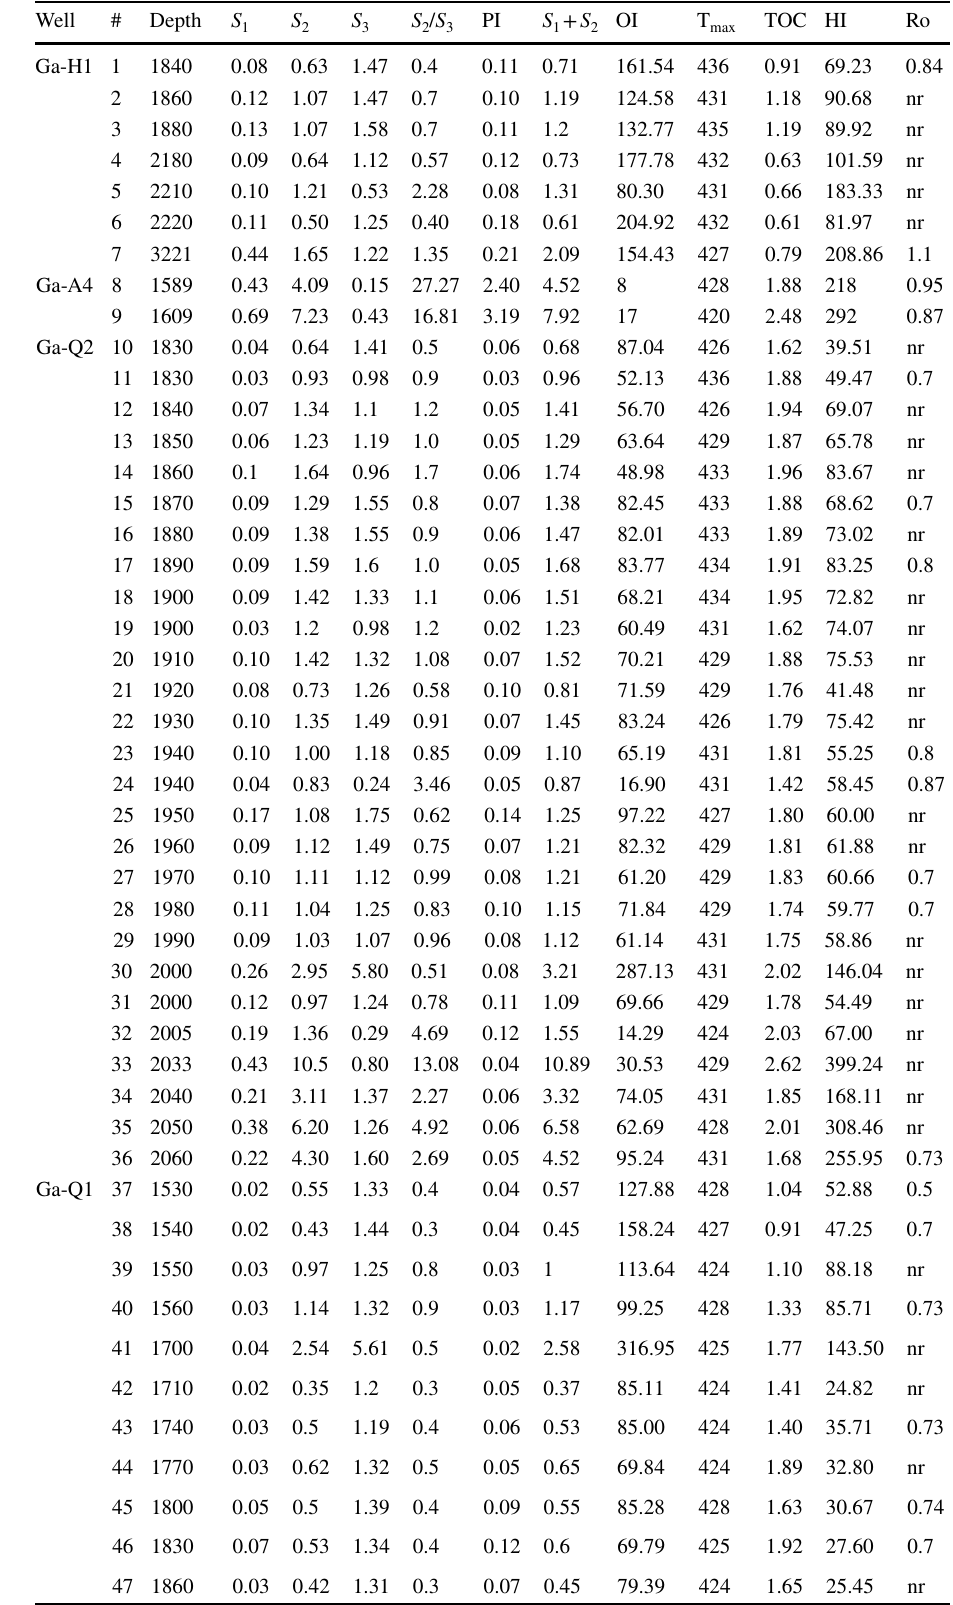
Table 1 Measure Rock–Eval pyrolysis and supplementary derived